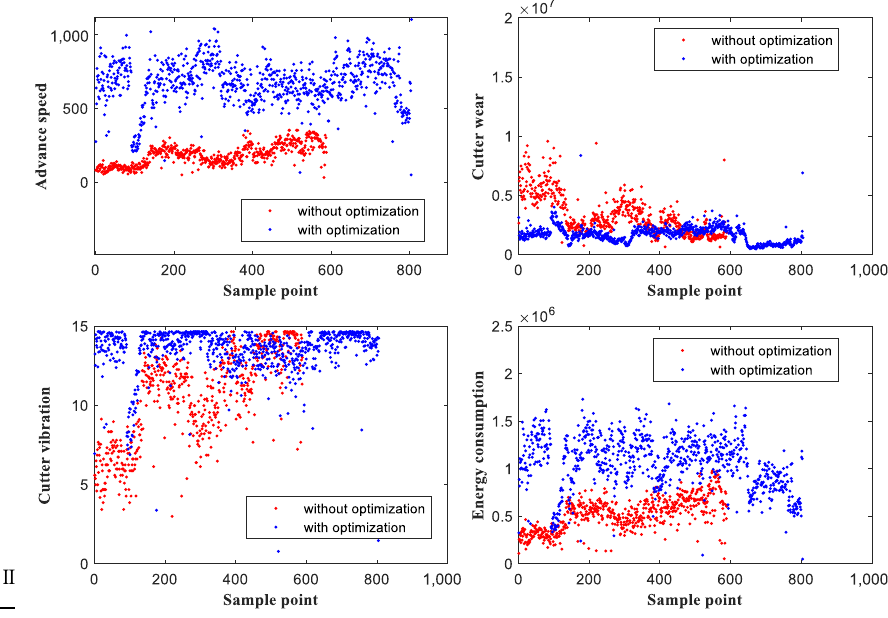
Figure 7. The optimization results under Granite